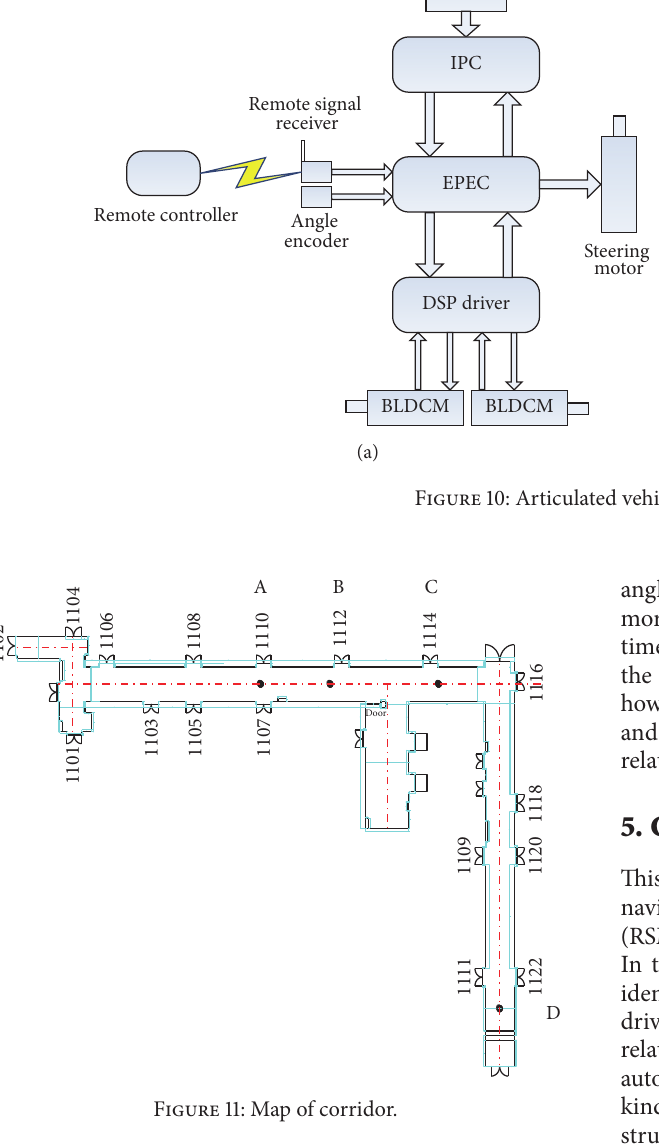
the articulated angle changes from left 11 ∘ to right 47 ∘ in manual mode, while it changes from left 10 ∘ to right 40 ∘ in auto mode. The smaller fluctuation of the